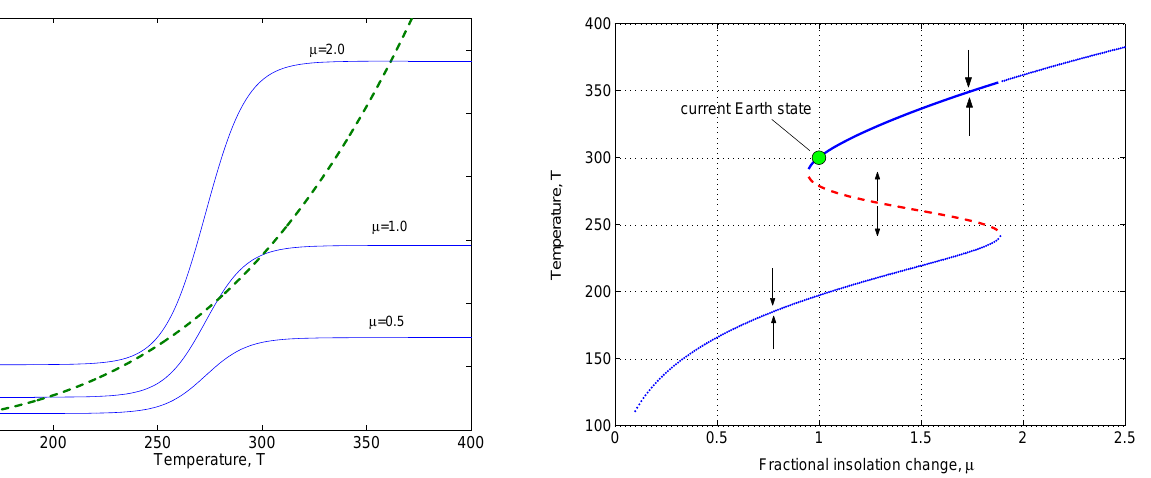
Fig. 5. Equilibrium solutions of the EBM (15) depending on the fractional change 𝜇 in insolation. Notice the existence of two sta- ble (blue, solid lines) and one unstable (red, dashed line) solution branches. The arrows show the direction in which the global tem- perature will change after being displaced from a nearby equilib- rium state by external forces. The current Earth state corresponds to the upper stable solution at 𝜇 = 1 ; in this figure 𝜅 = 0 . 05 .